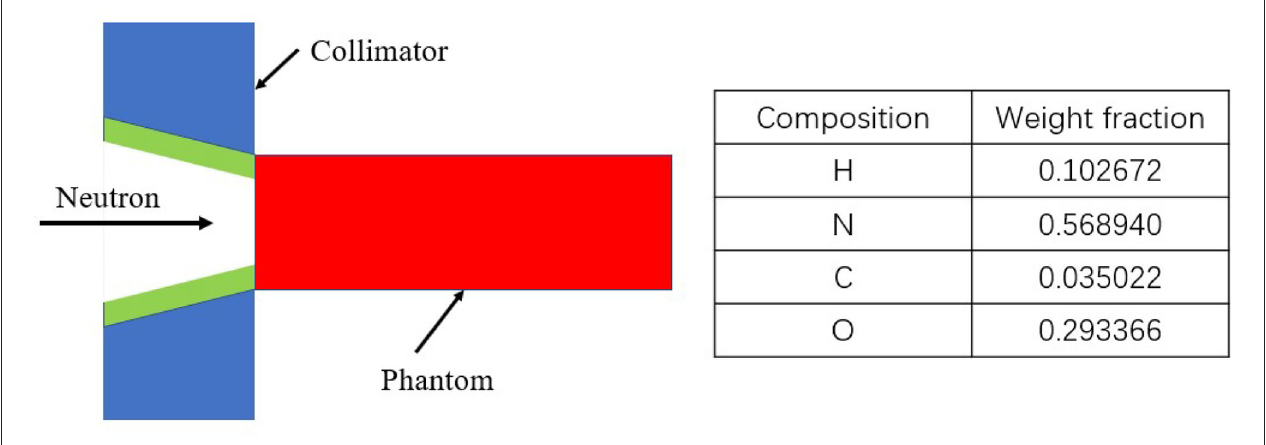
Frontiers in Public Health |